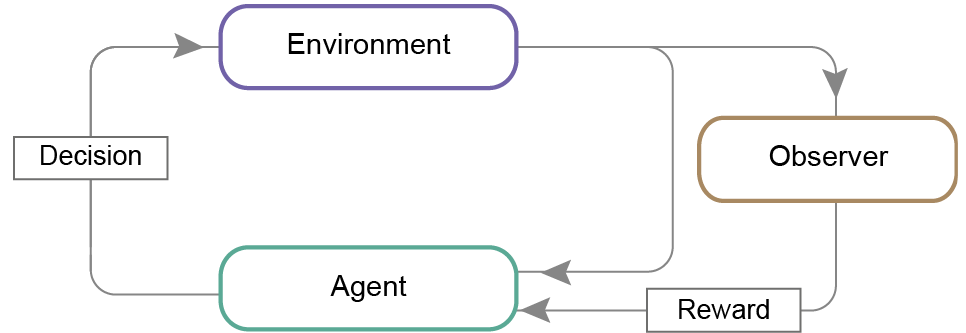
Figure 4. Reinforcement learning model. An agent in its current state performs an action, which influences the state of the environment. The environment gives back the information about its changed state to the agent. The supervisor interprets and rates the action, providing a reward for a correct decision.